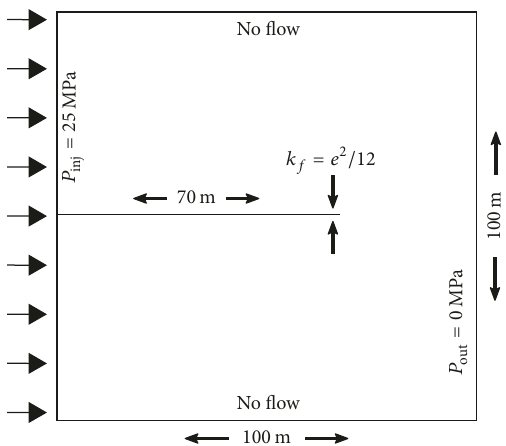
Figure 3: Numerical setup to evaluate the influence of fracture permeability on thermal stress. A constant injection pressure is applied to the left side of the domain. The right side serves as a zero pressure outflow